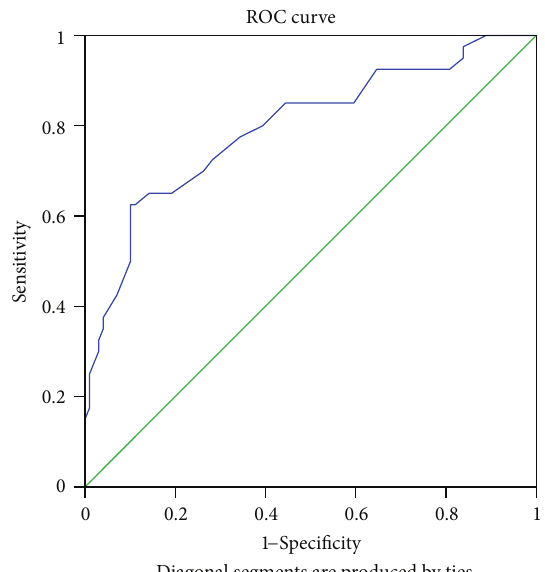
Figure 3: Receiver operating characteristics (ROC) curve (showing sensitivity and specify of the epicardial fat thickness to determine cutoff high risk value). The area under the ROC curve of 0.797 indicates a very good accuracy of the